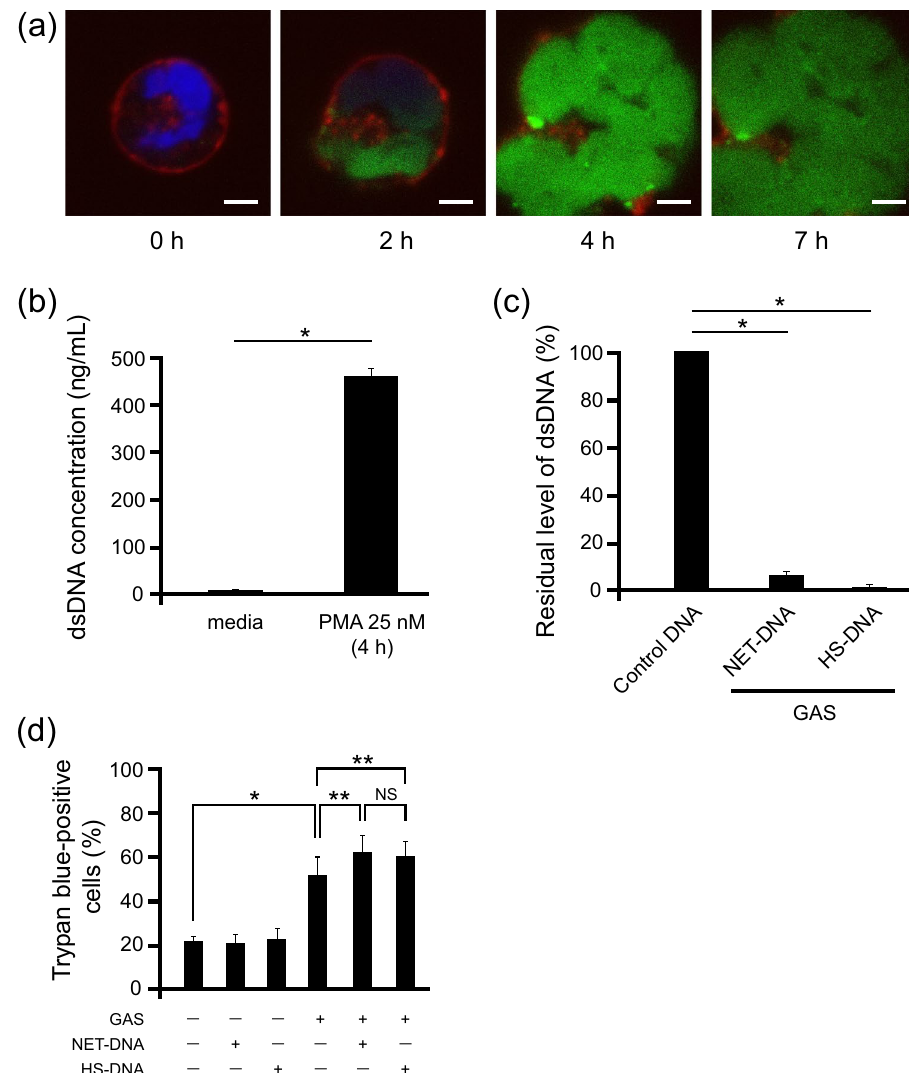
Figure 3. NET degradation products induce cell death in vitro . ( a ) Immunostained NETs. Neutrophils were stimulated with 25 nM PMA, immunostained with 500 nM SYTOX Green (green), 5 μ M DRAQ5 (blue), and 5 μ g/mL WGA (red), and incubated for the indicated times. Bars indicate 10 μ m. ( b ) The NET-DNA level in the supernatant separated by centrifugation was quantified using the Quant-iT PicoGreen dsDNA assay. Non- stimulated neutrophils stored at 8 °C for the same period were used as the control. * p < 0.01 (the Student’s t -test). ( c ) The dsDNA level in the supernatant of the co-culture of the ATCC 11434 strain with NET-DNA or HS-DNA. * p < 0.01 (the Student’s t -test). ( d ) The supernatant of the ATCC 11434 strain co-cultured with NET- DNA or HS-DNA was added to THP-1 cells. Trypan blue-positive cells were counted at 6 h and the ratio among the total cell count was calculated. * p < 0.01, ** p < 0.05, NS: not significant (the Student’s t